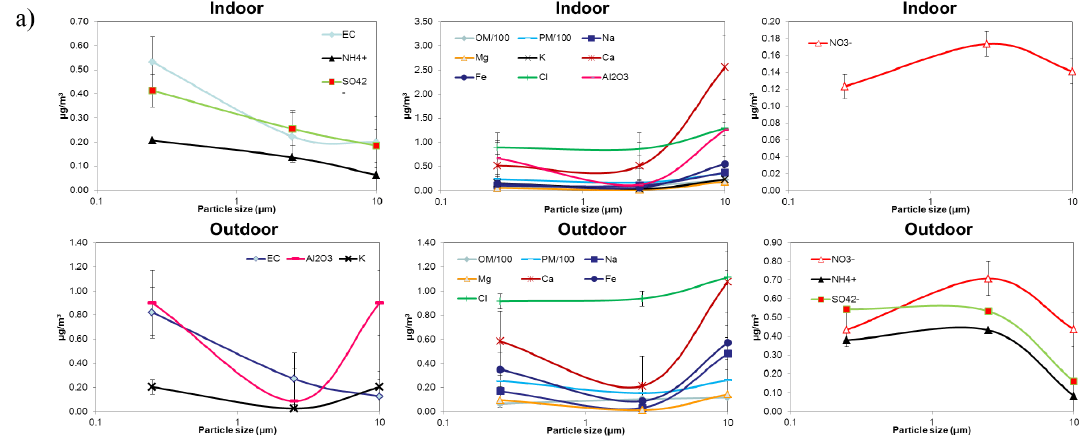
Fig. 3a. Average size distribution of major PM components in indoor and outdoor air, in terms of mass (µgm − 3 ) and including standard error bars.